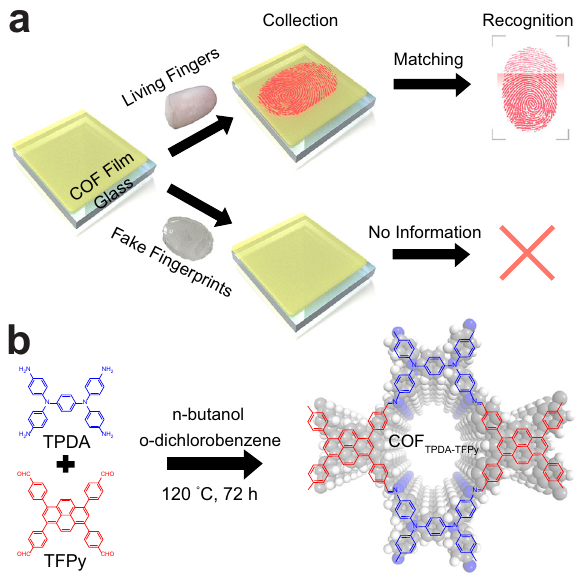
Fig. 1 | Material-based liveness detection with COF fi lm. a Schematic of the material-based liveness detection based on the COF TPDA-TFPy fi lm. b Chemical structures of monomers and COF TPDA-TFPy